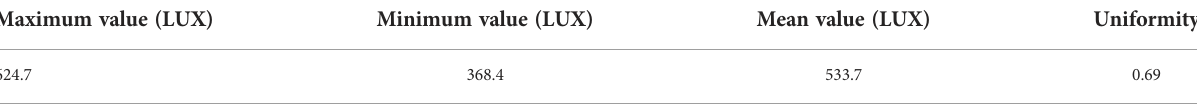
TABLE 1 The illumination distribution analysis with a lighting distance of